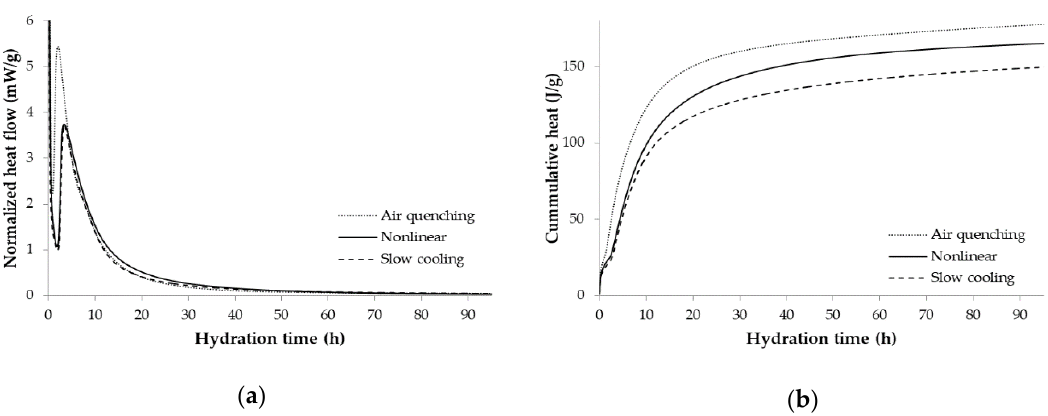
Figure 9. Hydration heat flow ( a ) and the development of cumulative heat of hydration ( b ) for the cements under varying cooling regimes.